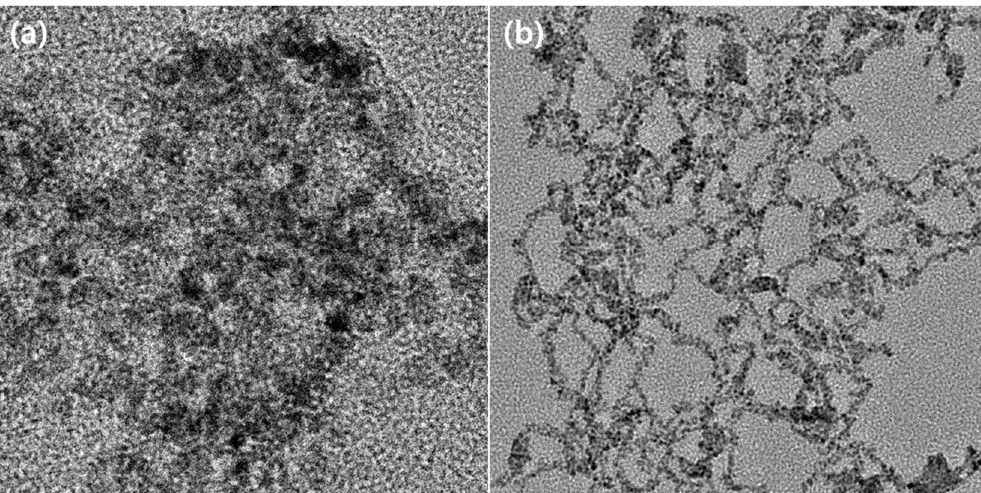
Figure 3. Transmission electron microscopy (TEM) images of cysteamine capped PbS quantum dots. ( a ) Image of cysteamine capped PbS quantum dot with 2-mercaptoethanesulfonate as additional ligand ( b ) Image of cysteamine capped PbS quantum dot without 2-mercaptoethanesulfonate. Unlike ( a ), ( b ) shows the severe aggregation of PbS quantum dots caused from hydrogen bonds of cysteamine molecules.